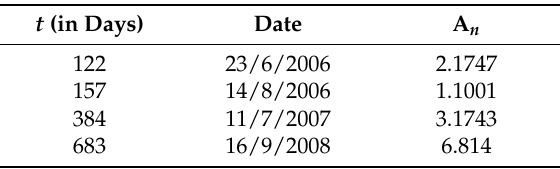
Table 16. Change points for the estimated negative jumps of Intel with the corresponding test statistic value .